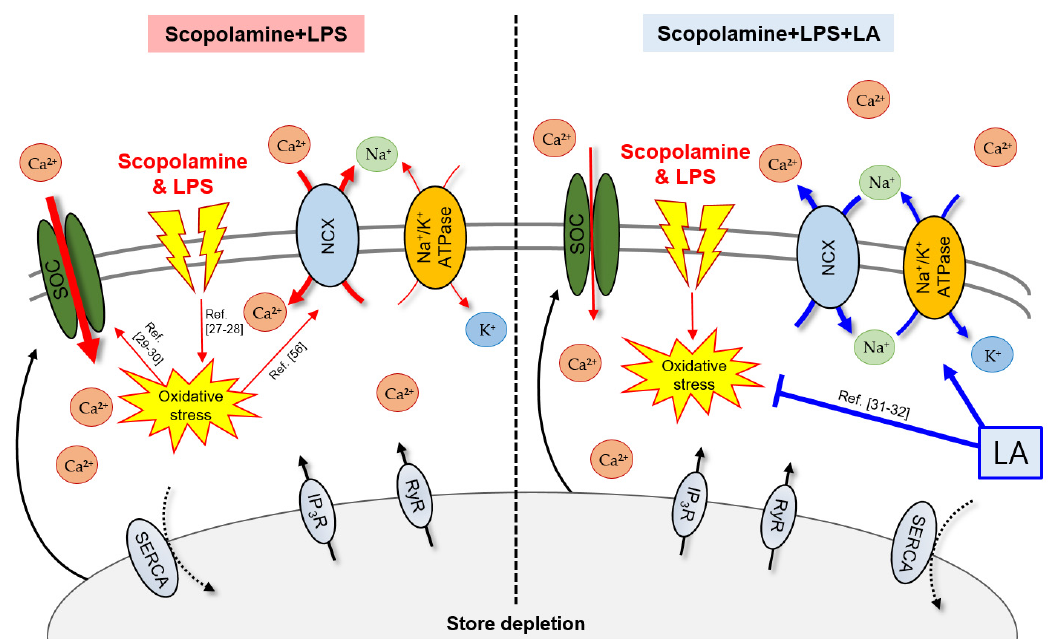
Figure 5. Proposed mechanisms of action of linalyl acetate (LA) on store-operated Ca 2+ entry (SOCE) in SH-SY5Y and BV2 cells exposed to scopolamine and lipopolysaccharide (LPS). Red arrows reflect the impact of scopolamine and LPS, and blue arrows reflect the effects of LA. The amount of Ca 2+ influx or efflux is indicated by the thicknesses of the arrows. IP 3 R, inositol 1,4,5-trisphosphate receptor; NCX, Na + /Ca 2+ exchanger; RyR, ryanodine receptor; SERCA, sarcoplasmic reticulum Ca 2+ ATPase; SOC, store-operated Ca 2+ channel.